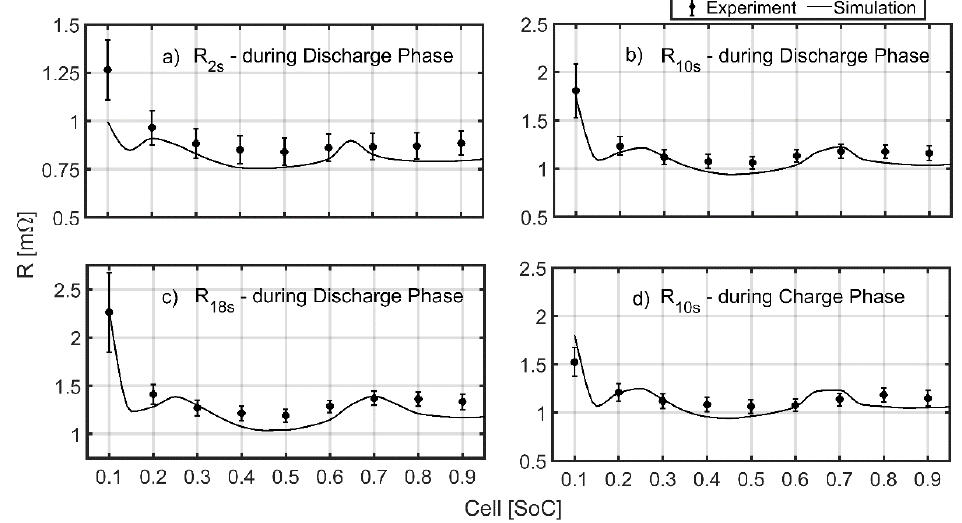
Figure 5. Experimental and simulated direct current resistance profiles R (mΩ) as a function of cell SoC at the times t = 2 s ( a ), 10 s ( b ), 18 s ( c ) after discharge initialization and t = 10 s ( d ) after charge initialization.